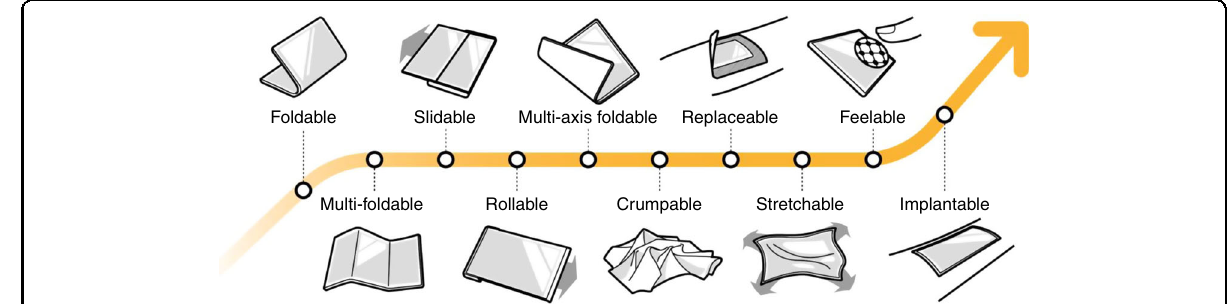
Fig. 1 Technological roadmap of deformable displays. It shows the form factor and functional innovation for deformable